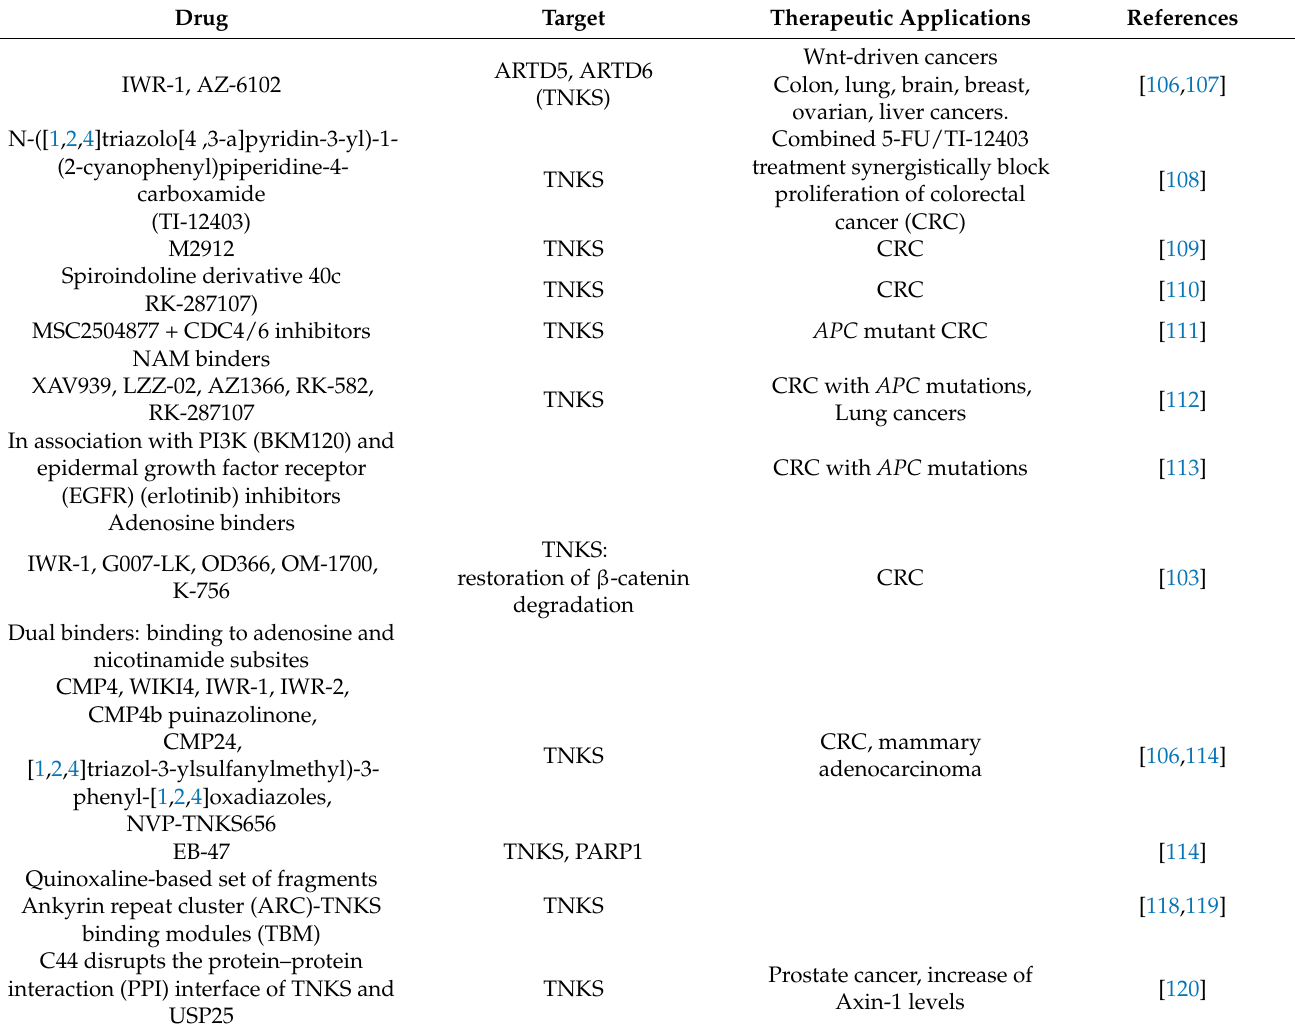
Table 2. Tankyrase inhibitors applied to cancer treatment: inhibitors stabilize and increase Axin levels and decrease nuclear β -catenin